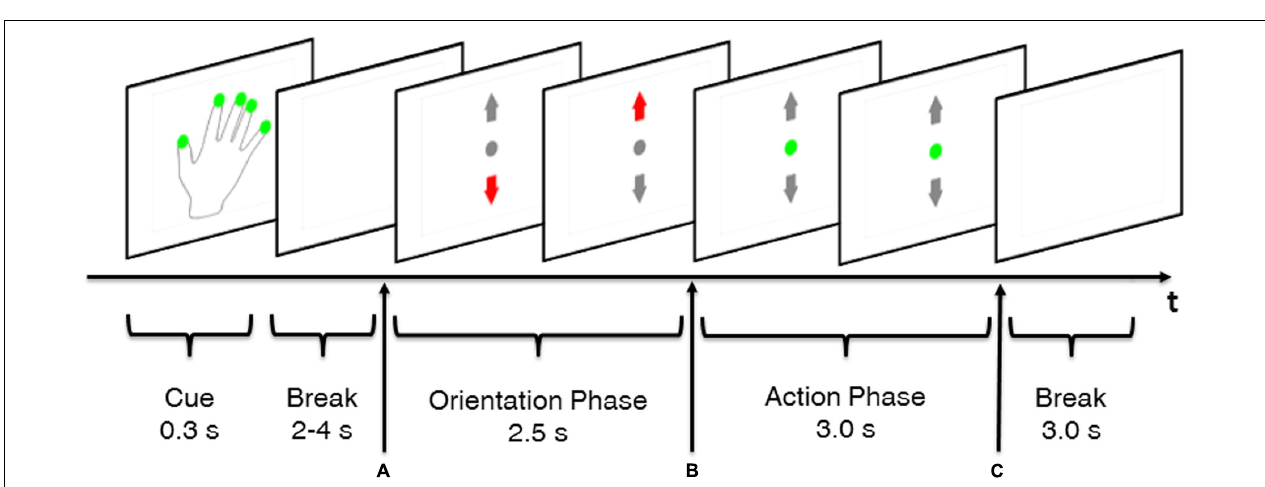
FIGURE 2 | Time course of a MT trial. Green dots on the fingerprints of the cue hand indicated that a non-REST trial was performed, i.e., execution of the MT. A random break taking between 2 and 4 s gave the subject enough time to place his fingers on the force sensors that were attached to the cylinder. Appearance of visual feedback (A) served as GO cue to apply grip force. An orientation phase gave the subject time to adapt his grip force to the predefined target force. Grip force was evaluated during the action phase (B,C) to determine whether the subject’s force was in the target range. Disappearance of the visual feedback (C) served as STOP cue. Each trial was followed by a 3.0 s inter-trial